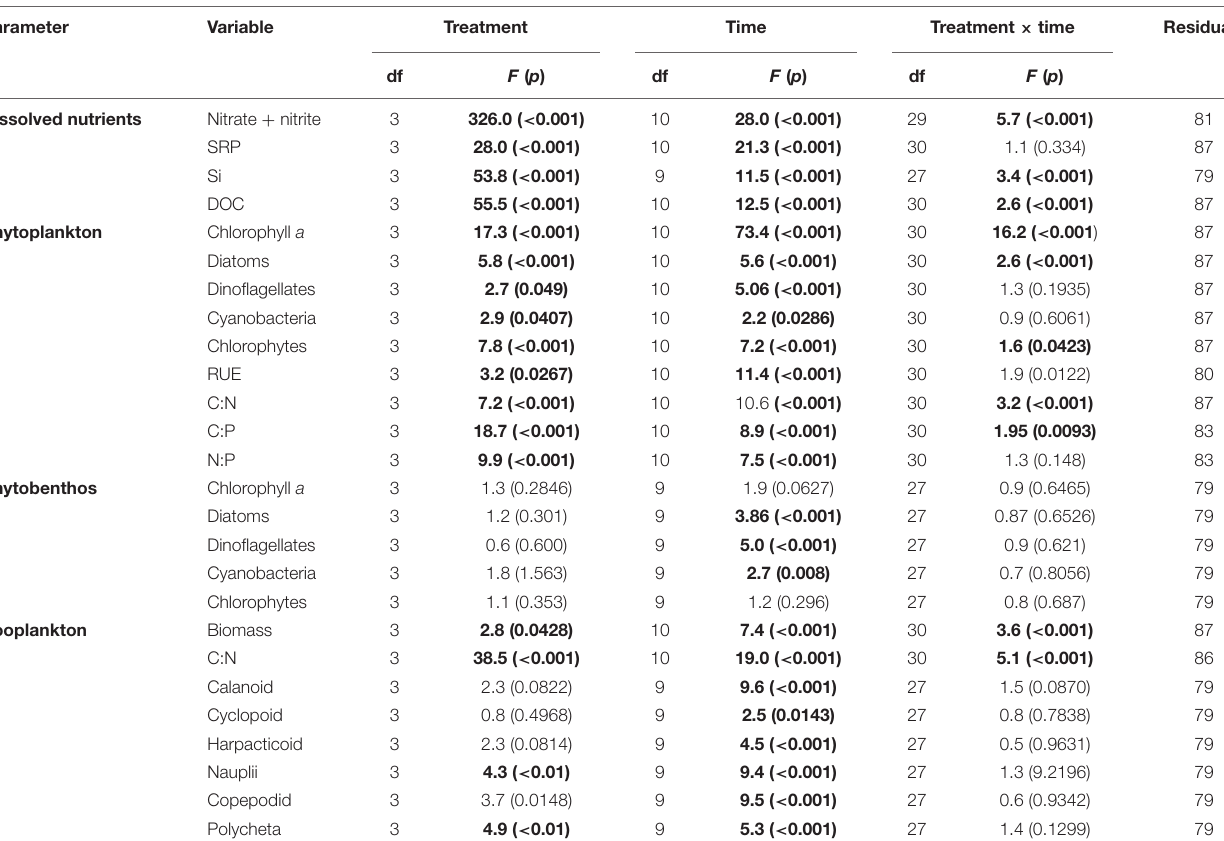
TABLE 1 | Summary of repeated measures ANOVA model, showing the effect of treatment (tDOM addition), time (using “day”) and their interaction. Parameter